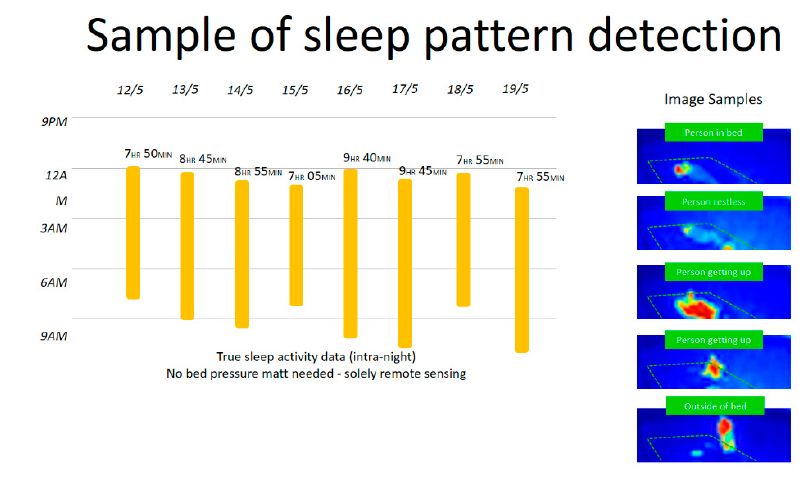
Figure 10. Sample of sleep detection.